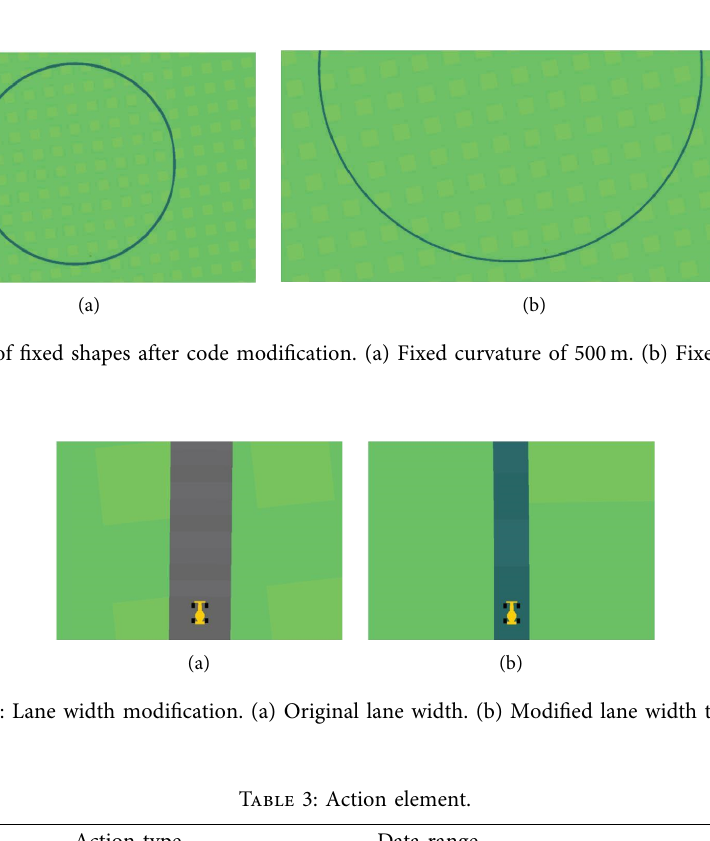
Figure 2: Randomly generated courses in CarRacing-v0. (a) Random course generation example 1. (b) Random course generation example 2.